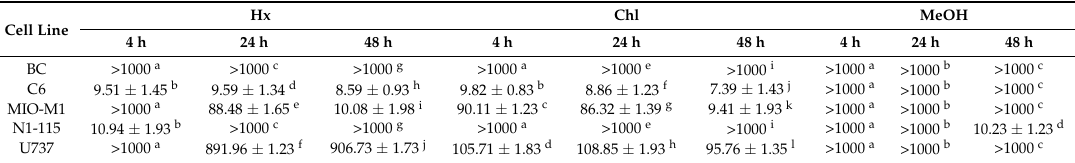
Table 1. Half maximal inhibitory concentration (IC 50 ) [ µ g/mL] of the extracts of E. menziesii against nervous system cancer cell